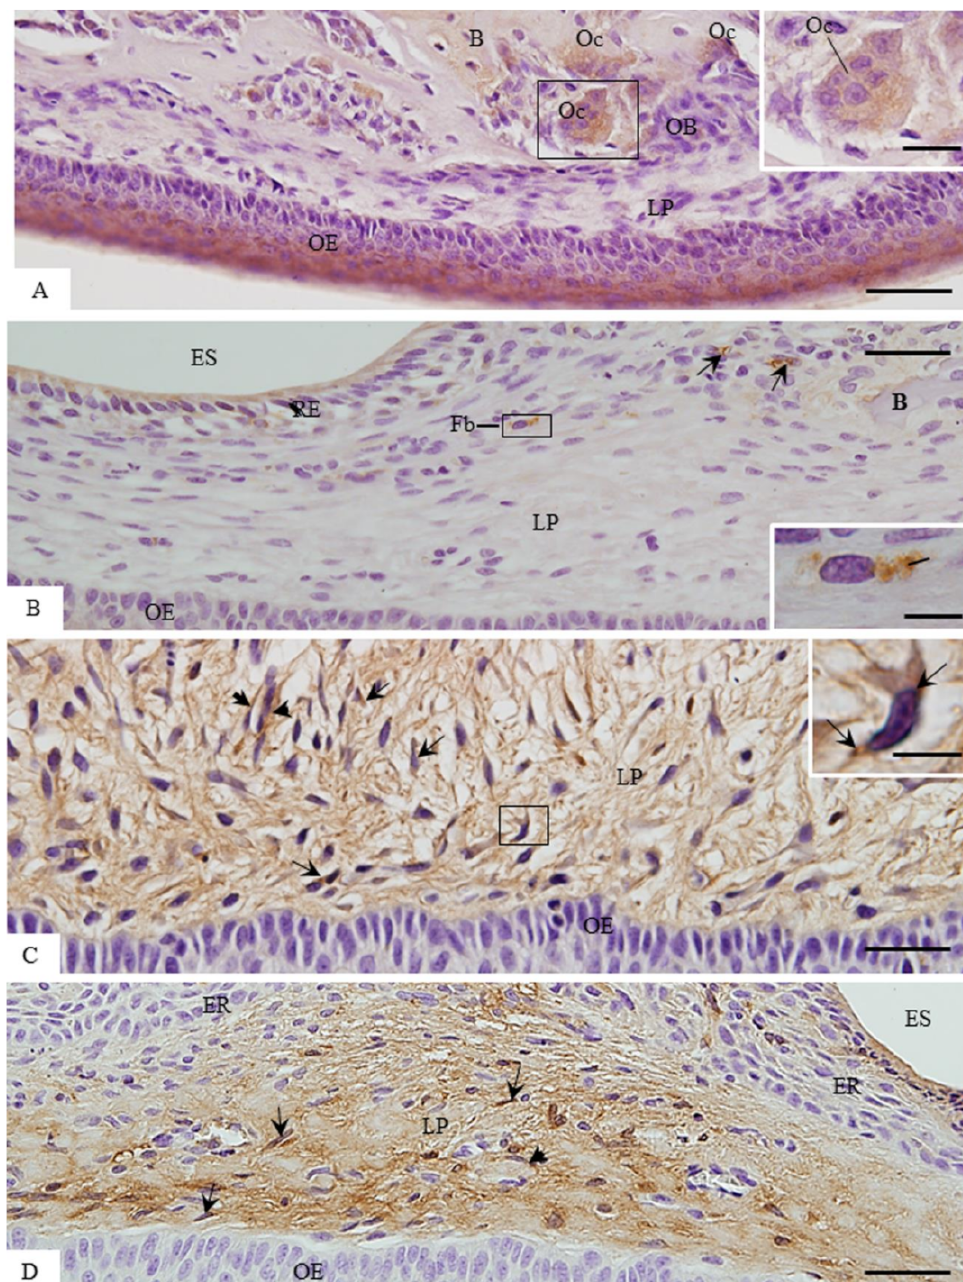
Figure 7. Light micrographs of portions of oral mucosa of the eruptive pathway of first molars subjected to the immunohistochemistry for detection of ACP-2 (brown-yellow colour) and counterstained with haematoxylin. In A (9-day-old rat) and B (11-day-old rat) scarce immunolabelled cells (arrows) are observed in the eruptive pathway. In A , ACP-2 immunolabelled multinucleated osteoclasts (Oc) are present in the bone ( B ) surface. The inset, outlined area in A , shows immunolabelled osteoclast (Oc) cytoplasm. LP, lamina propria. Bars: 40 µ m and 15 µ m (inset). In B , an immunolabelled fibroblast (Fb) is observed between the lamina propria (LP) and reduced enamel epithelium (RE). Immunolabelled cells (arrows) are observed next to the bone (B) surface. The inset, outlined area, shows conspicuous immunostaining in the fibroblast cytoplasm (Fb). OE, oral epithelium; ES, enamel space. Bars: 40 µ m and 6 µ m (inset). In C (13-day-old rat) and D (16-day-old rat), several immunolabelled fibroblasts (arrows) are seen in the lamina propria (LP). In the inset, outlined area of C , strong immunostaining is observed in the cytoplasm of a fibroblast (arrows). ACP-2-positive immunolabelling is observed in the endothelial cells (arrowheads). ES, enamel space; ER, reduced enamel epithelium; OE, oral epithelium. Bars: 40 µ m ( C and D ) and 6 µ m